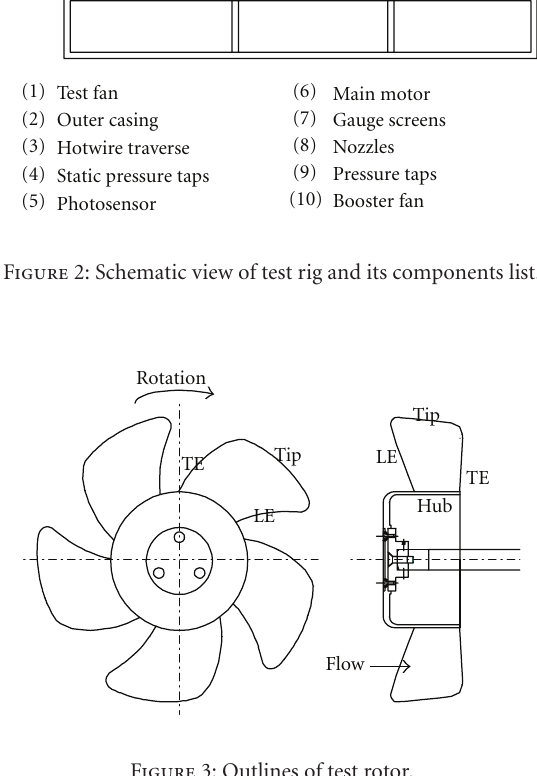
Figure 1: Types of small axial fan and image of inlet flow pattern.